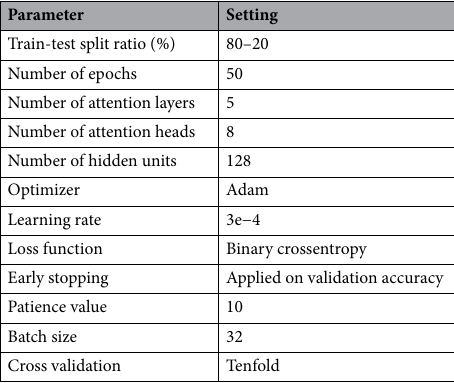
Table 2. The parameter settings of the proposed APP